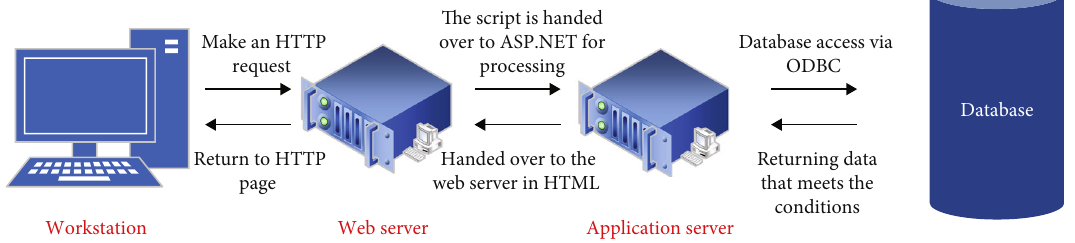
Figure 2: Network topology diagram of the comprehensive evaluation teaching quality evaluation system based on